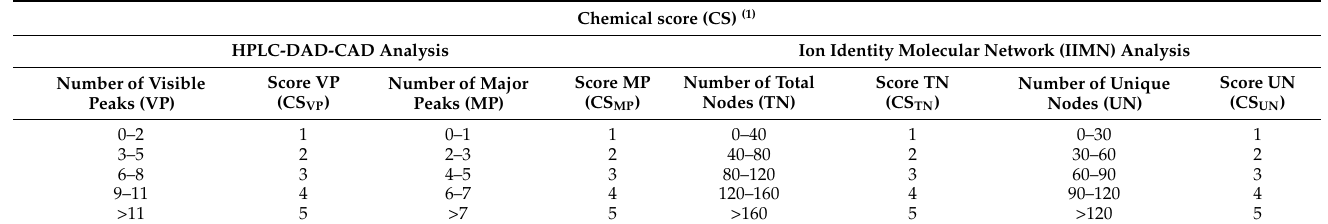
Table 4. Description of the scoring methodology for each score assigned to the strains’ extracts (chemical, biological and novelty score).